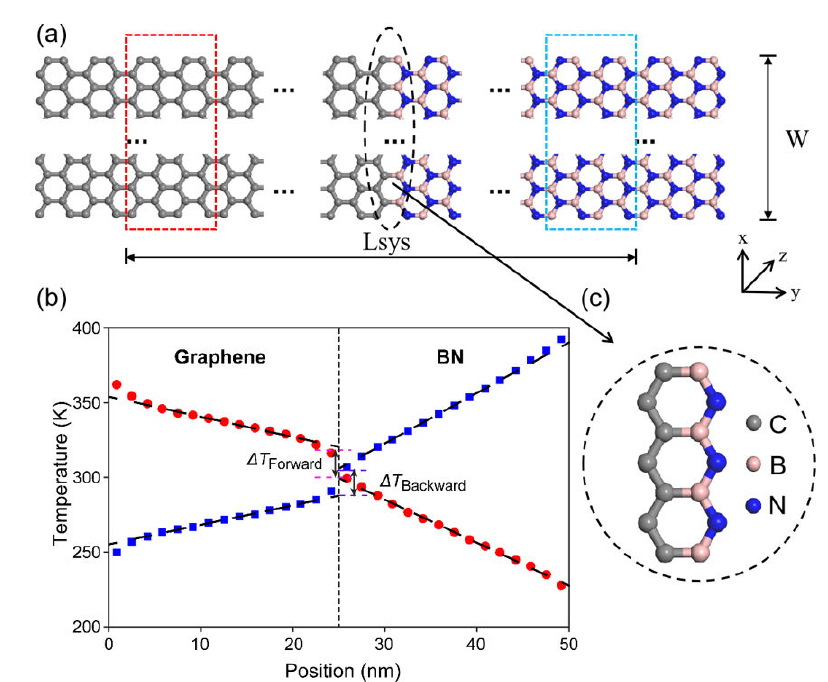
Figure 1. ( a ) Simulation system of the nanosheet thermal diode. It is formed by connecting the graphene and boron nitride (BN) in equal proportion. Red and blue dashed lines represent heating area and cooling area, respectively. Heat flows from graphene to BN (forward) or from BN to graphene (backward). ( b ) Temperature profile of a 50 nm long system reaching a steady state after heat equilibration. The red data points represent the forwards direction, while the blue ones represent the backwards direction. ( c ) Detailed view of the interface formed by C-B-N